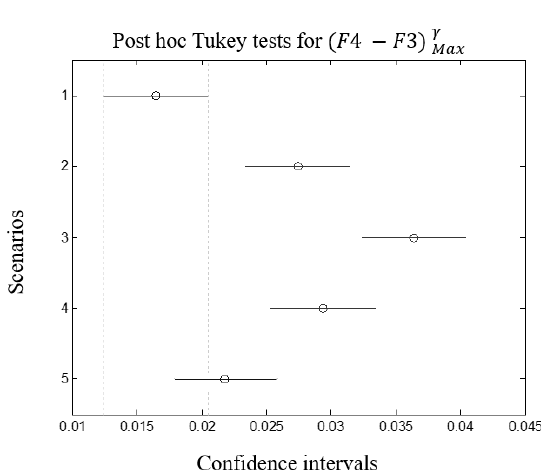
Figure 12. From left to right: differences between scenarios reported by Tukey tests for FC 5 θ AF 4 α , AF 4 β , AF 4 γ Max Max Max